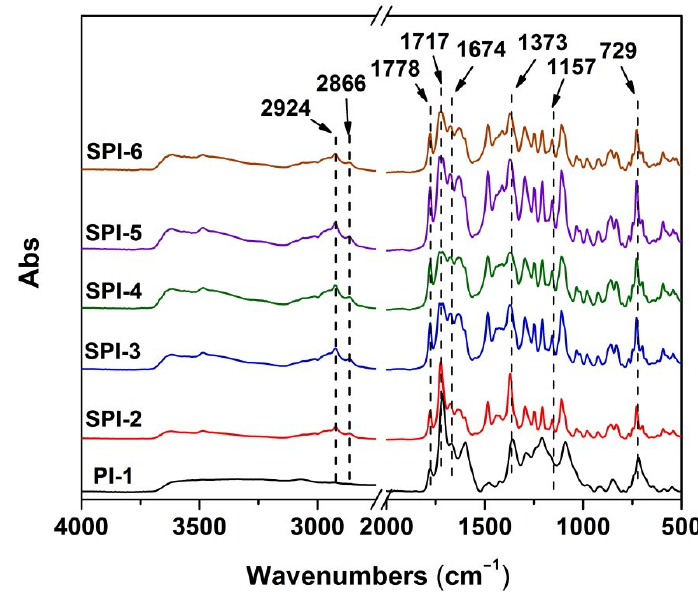
Figure 7. ATR-FTIR spectra of PI-1 and the SPI NFMs.